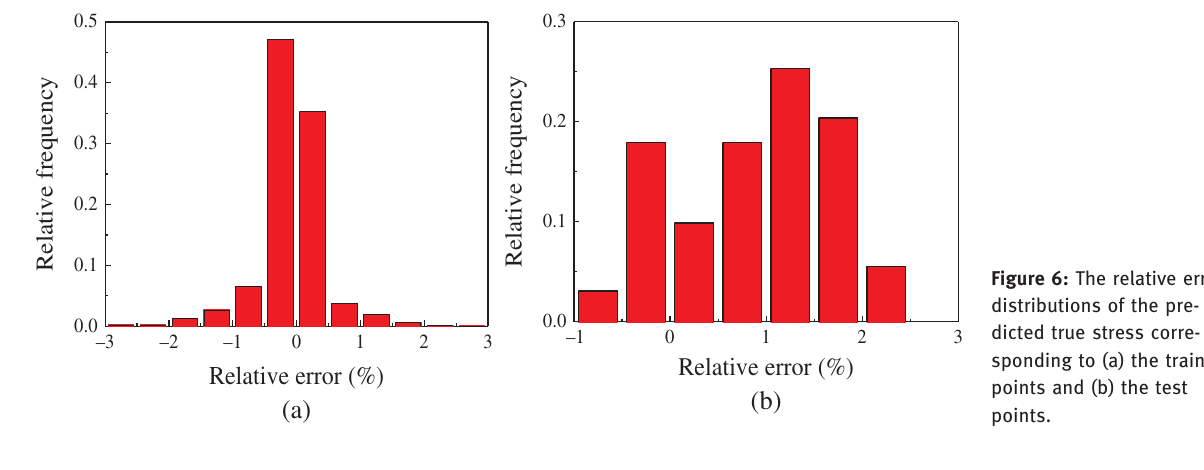
Figure 6: The relative error distributions of the pre- dicted true stress corre- sponding to (a) the training points and (b) the test points.